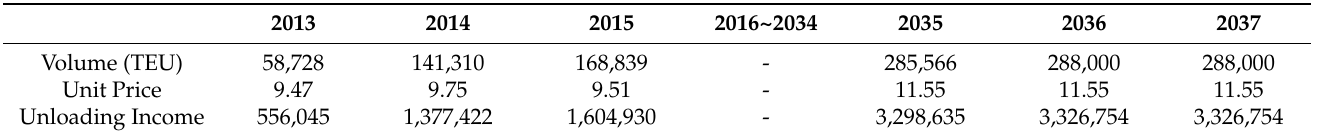
Table 5. Estimated unloading/loading income (unit: U.S.